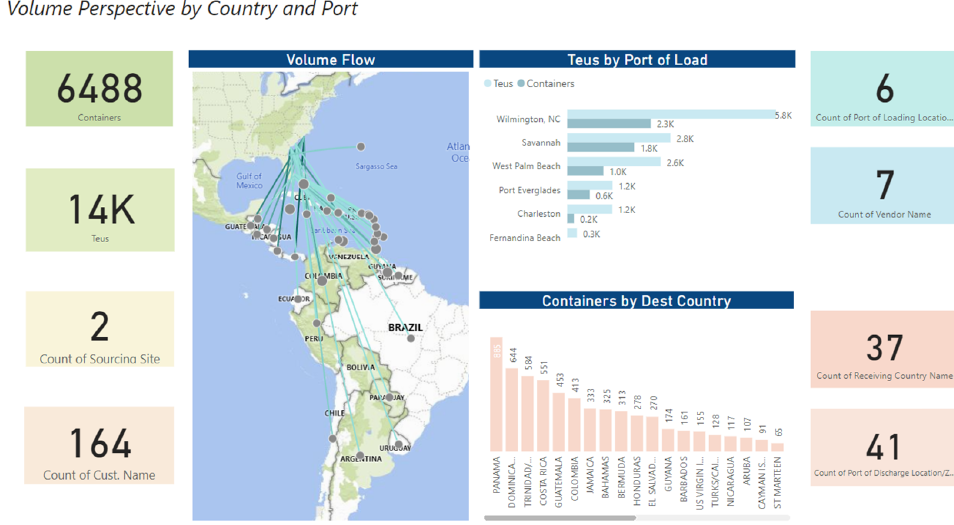
Figure 3. Volume Perspective by Country, Port of Load, and Port of